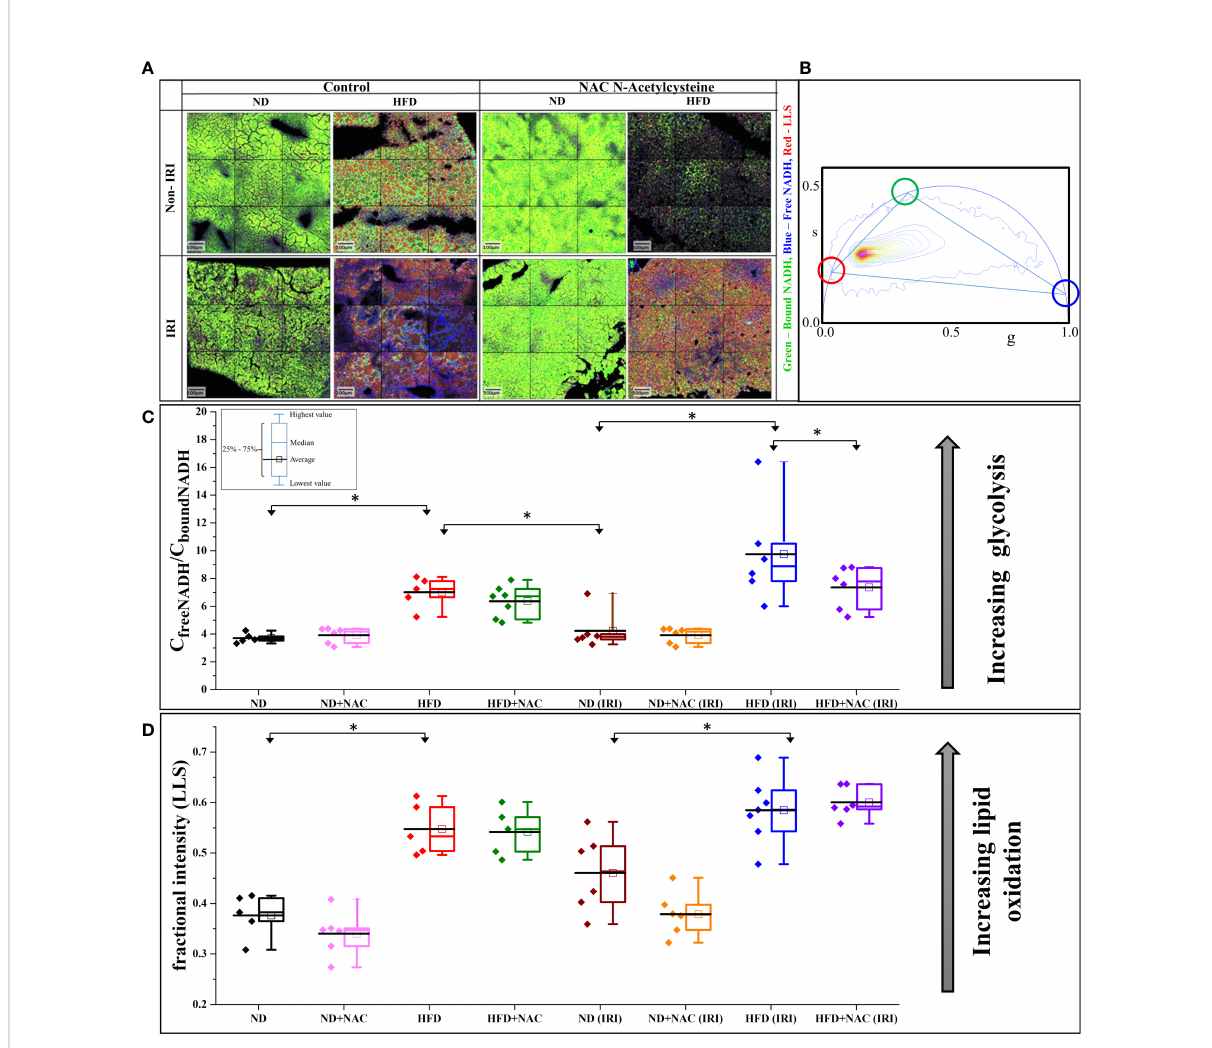
FIGURE 3 IRI results in a higher degree of glycolytic stress in HFD mice. (A) Color mapped Phasor FLIM images of the ND and HFD liver samples in the absence (left) and presence (right) of NAC supplementation. The top row shows the sham samples, and the bottom row shows the IRI samples. More green, blue and red color represents more protein-bound NADH, free NADH and long lifetime species (LLS), respectively. (B) Phasor plot of auto fl uorescence FLIM in liver samples – the three colored circles represent the lifetime position of the three components: free and bound NADH, and LLS. (C) The concentration ratio of free to bound NADH was calculated from each mouse. The higher value represents more glycolytic stress. There is a higher level of glycolytic stress in HFD and HFD (IRI) samples. This is reduced in the HFD + NAC (IRI) samples, but not the HFD + NAC samples, respective to their HFD counterparts. (D) The fractional intensity of LLS calculated using three-component calculations to show the increasing LLS in high fat liver and how that increases with IRI (n=5-7 mice per group for both analyses). “ * ” 0.05 to